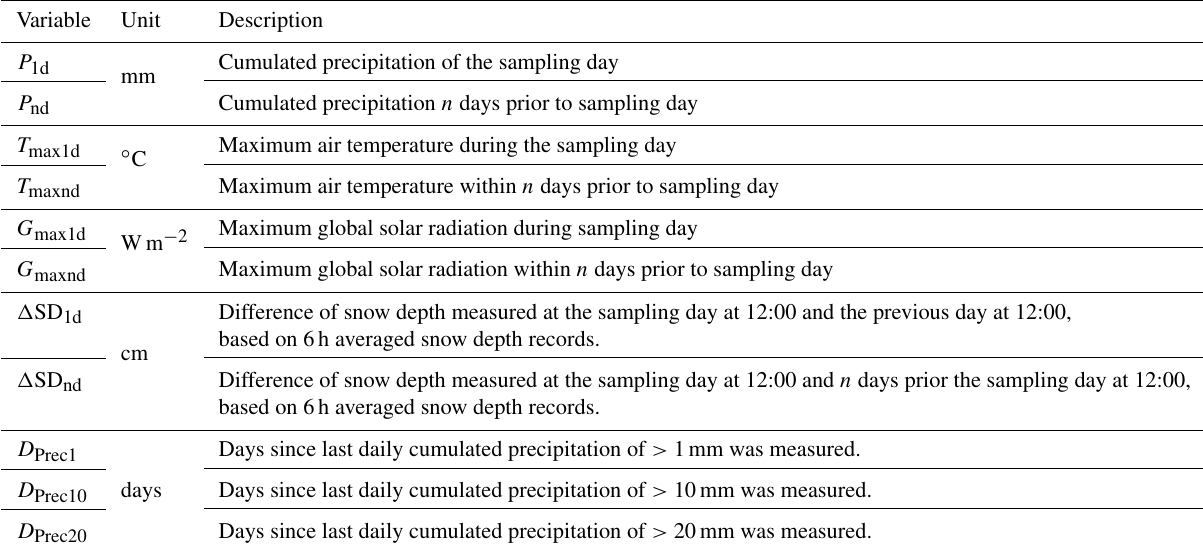
Table 3. Nivo-meteorological indicators derived from the weather station Madritsch (Madriccio) at 2825ma.s.l.